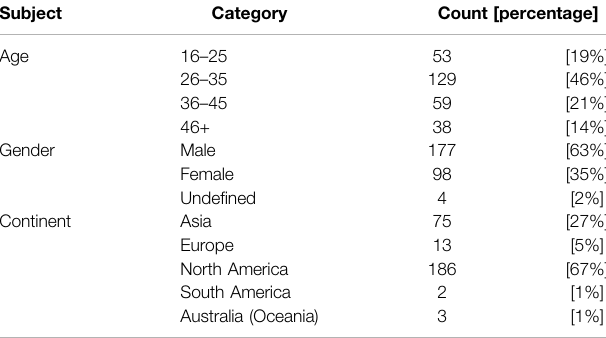
TABLE 3 | Participants ’ demographic information ( N (cid:2)